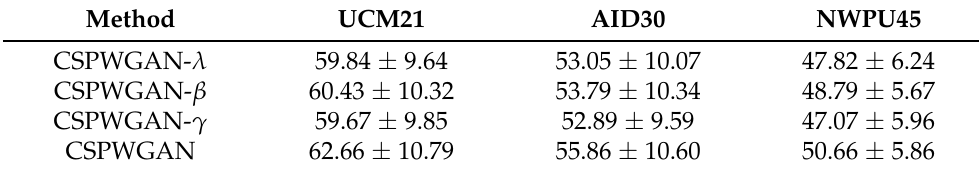
Table 5. Ablation results on the UCM21, AID30, and NWPU45